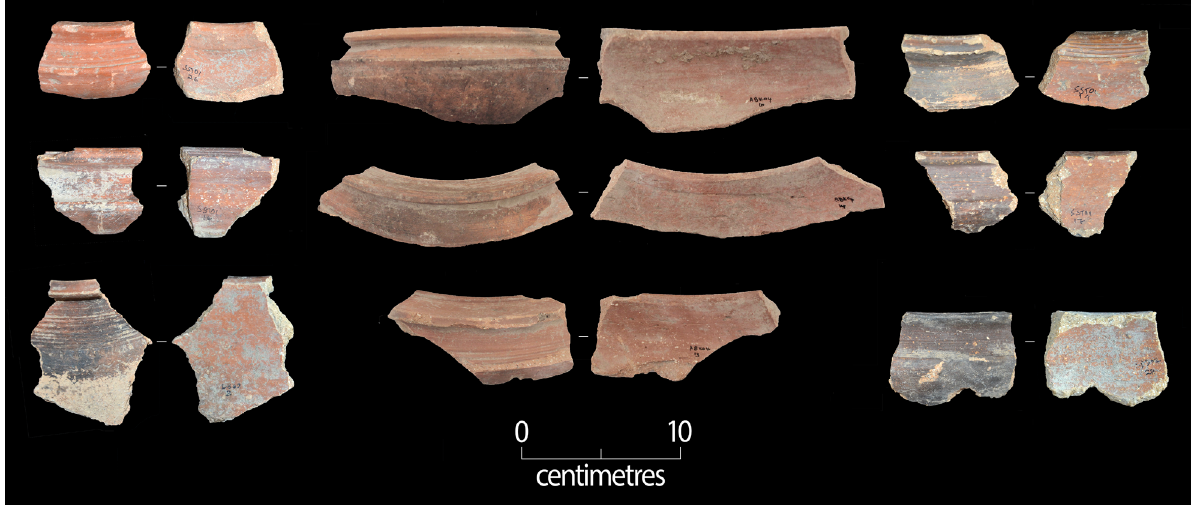
Figure 42: External and internal surfaces of Class 15 variant 1 potsherds.